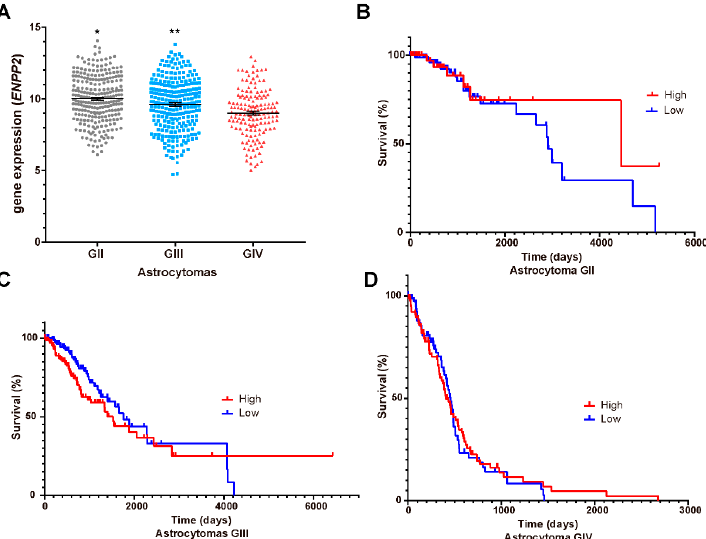
Figure 7. ENPP2 mRNA expression and astrocytoma patient’s survival. ( A ) ENPP2 mRNA expression (RNA-seq Illumina HiSeq, log2(norm count + 1)) in TCGA datasets ± SEM in different grades (G) of astrocytomas. The one-way ANOVA statistical test followed by a Tukey post-test determined the statistical difference. * p < 0.05 GII vs. GIII and GIV, ** p < 0.05 GIII vs. GII and GIV. The Kaplan–Meier graphs show survival curves in patients that express low or high levels of ENPP2 in astrocytomas ( B ) GII, ( C ) GIII and ( D ) GIV (GBM). Statistical analysis between high and low expression of ENPP2 was performed with a Log-rank (Mantel–Cox) test. No statistical difference was observed.